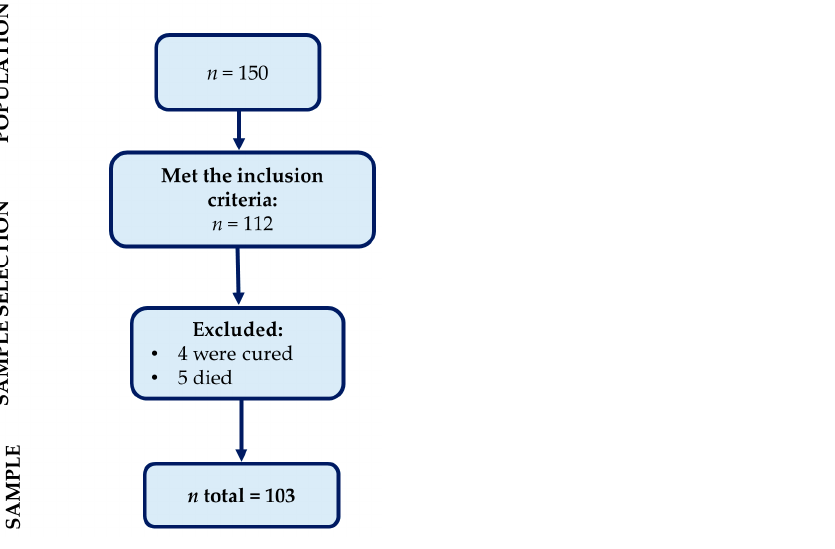
Figure 1. Flowchart of the recruitment process and sample selection.